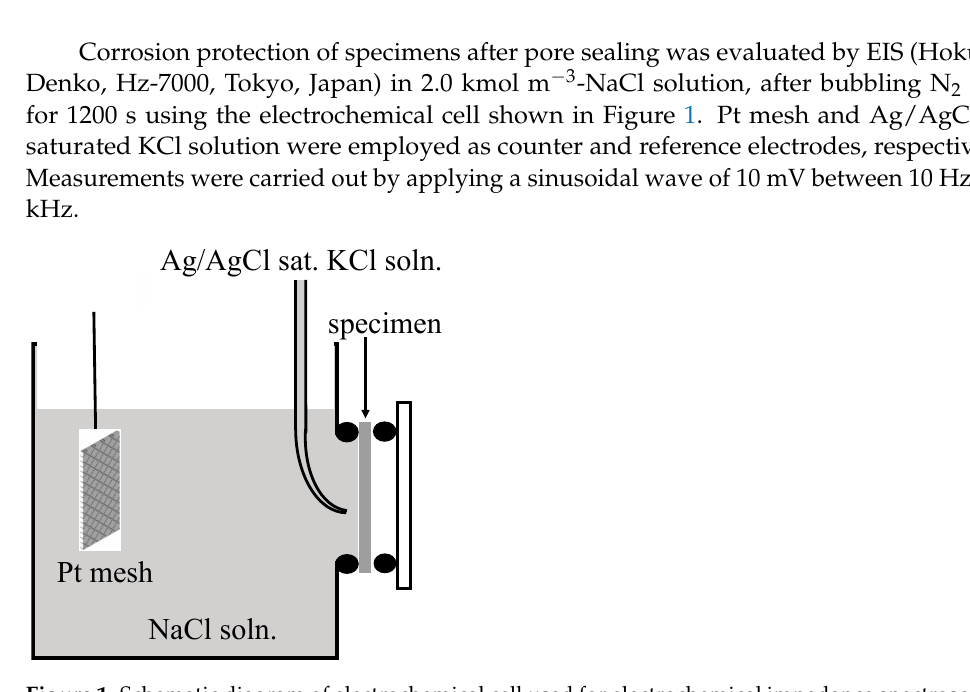
Table 1. Chemical composition and thickness of pure Al and Al alloys specimens.